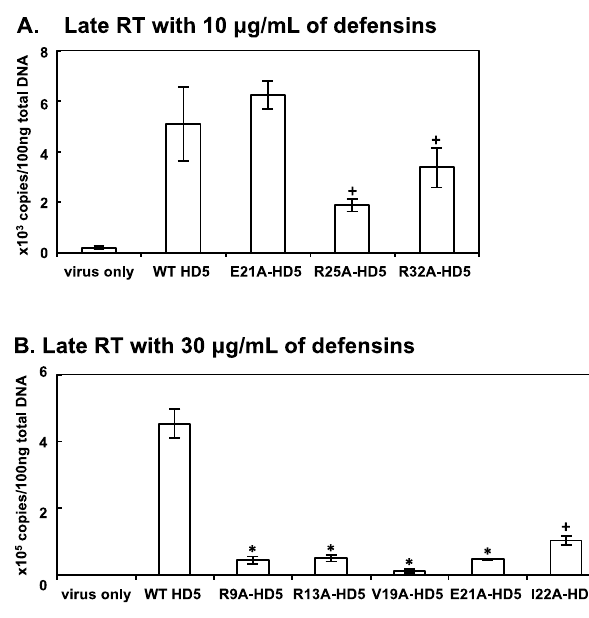
Figure 3. Effect of selected HD5 mutants on HIV reverse transcription. WT HD5 or HD5 mutants at 10 μ g/mL ( A ) or 30 μ g/mL ( B ) were pre-incubated with serum-free HIV-1 JR-FL for 1 h followed by infection of HeLa-CD4-CCR5 cells. After washing off unbound viruses, cells were cultured for an additional 12 h at 37 °C before preparation of total DNA for the analysis of HIV-1 late RT by quantitative real-time PCR. The baseline of RT copy numbers from cells infected by HIV without defensins was 204–236. * p < 0.05, WT HD5 versus HD5 mutants at the same concentration; Student’s t -test. The difference between WT HD5 versus R25A-HD5 (10 μ g/mL), R32A-HD5 (10 μ g/mL), and I22A-HD5 (30 μ g/mL) was not significant after Bonferroni correction, (+ p > 0.05).